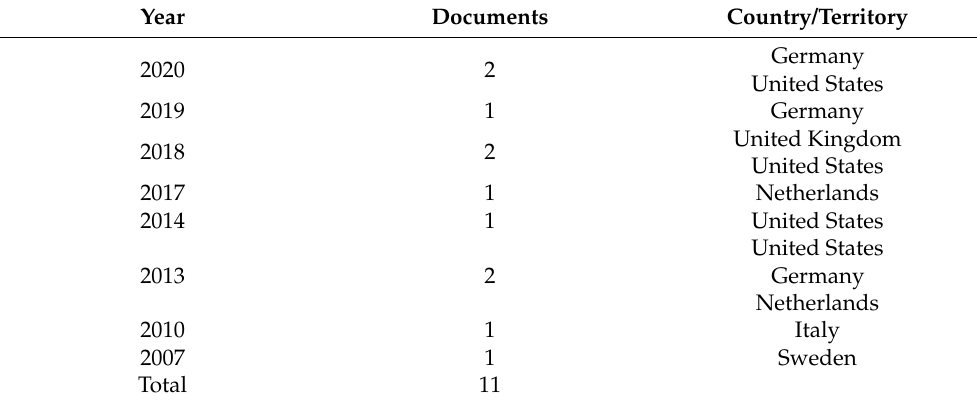
Figure 4. The search results by country and territory for the (TITLE-ABS-KEY (business AND informatics) AND TITLE-ABS-KEY (cohort AND analysis)) query during the 2007–2020 period. Table 2. Review of cohort analysis usage in business informatics in Scopus indexed research